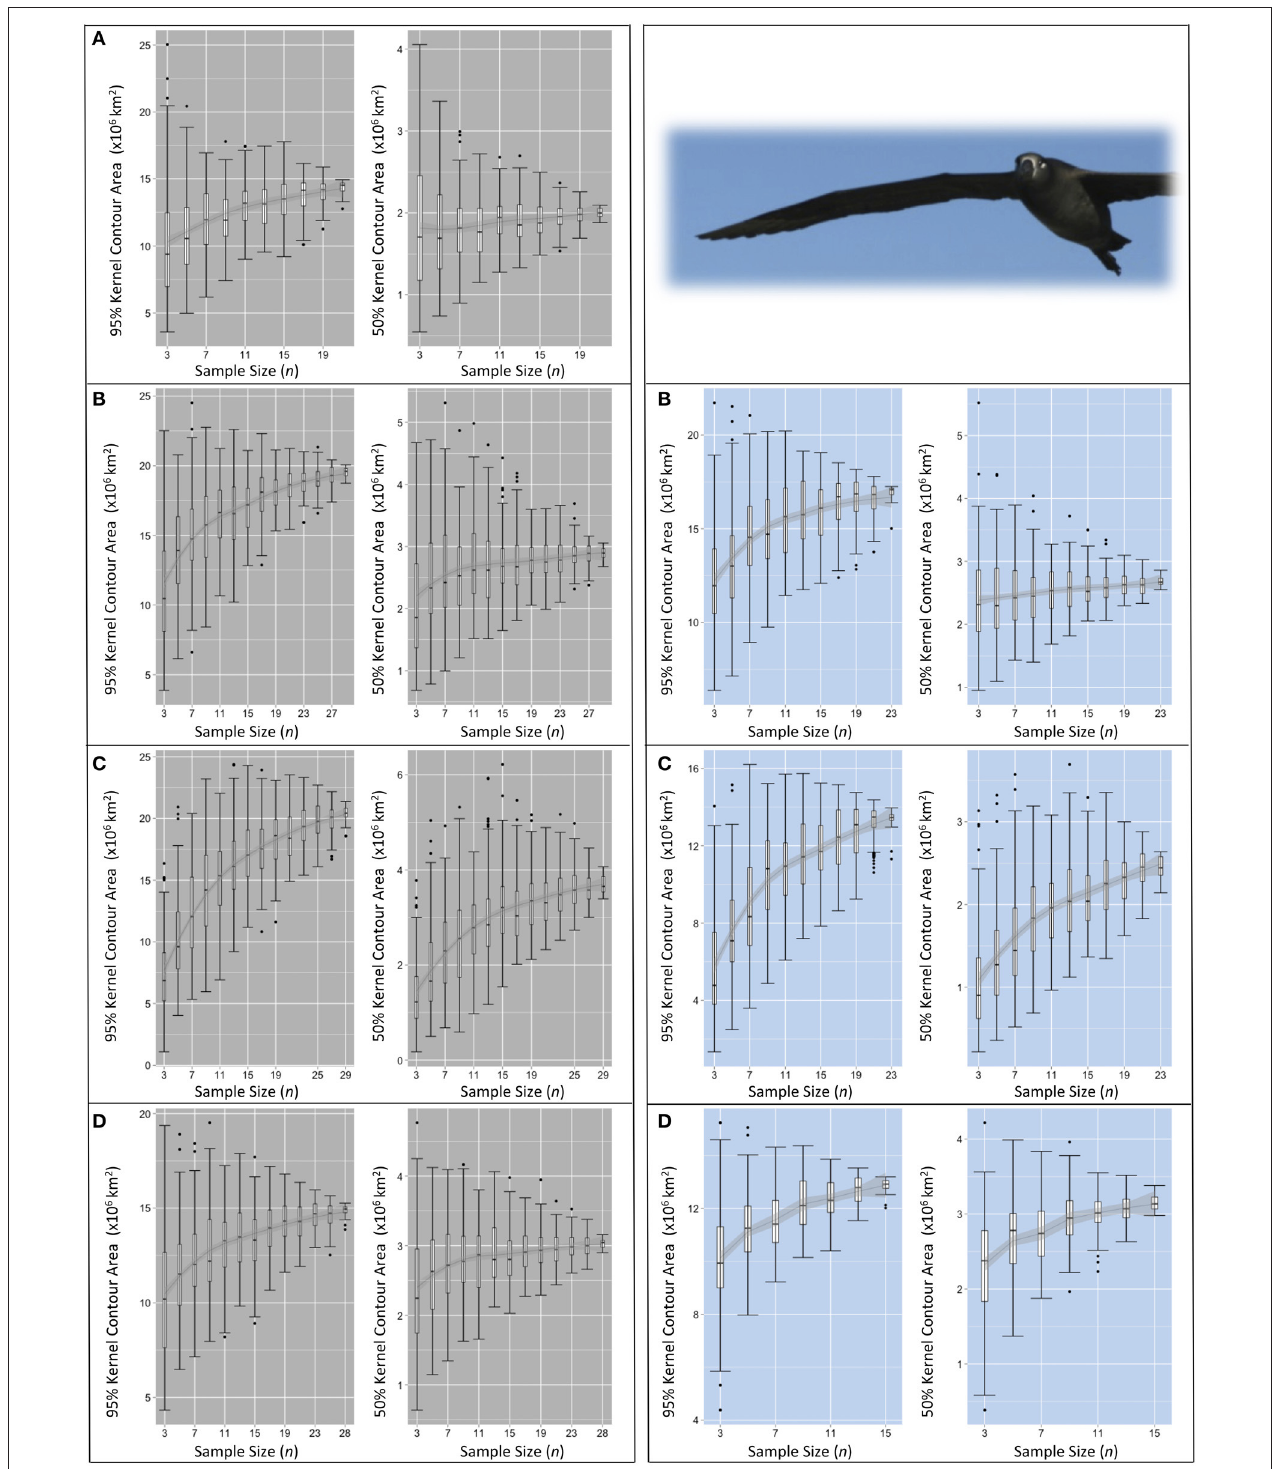
FIGURE 6 | Pooled KDE contour areas for black-footed albatross from two colonies during four periods of the annual cycle. Pooled KDE contour area (km 2 ) outputs for black-footed albatross from colonies at Midway (left panes in gray) and Tern (right panes in blue). Boxplots for each sample size (from n = 3 to n = max n –3) represent the 95 and 50% kernel contour areas of 100 iterations of KDE generated from the daily locations of n randomly selected individuals’ GLS tracks. The final boxplot in each panel depicts the results of KDE iterations of max n –1 (i.e., removing one individual from the dataset for each KDE), resulting in max n number of total iterations. Each set of four panes represent the four periods of the annual cycle: (A) ECR (insufficient data for Tern), (B) LCR, (C) OW, and (D) PBE (see Figure 1 ). LOESS smoothers are for visual interpretation and should be used only as a guide.